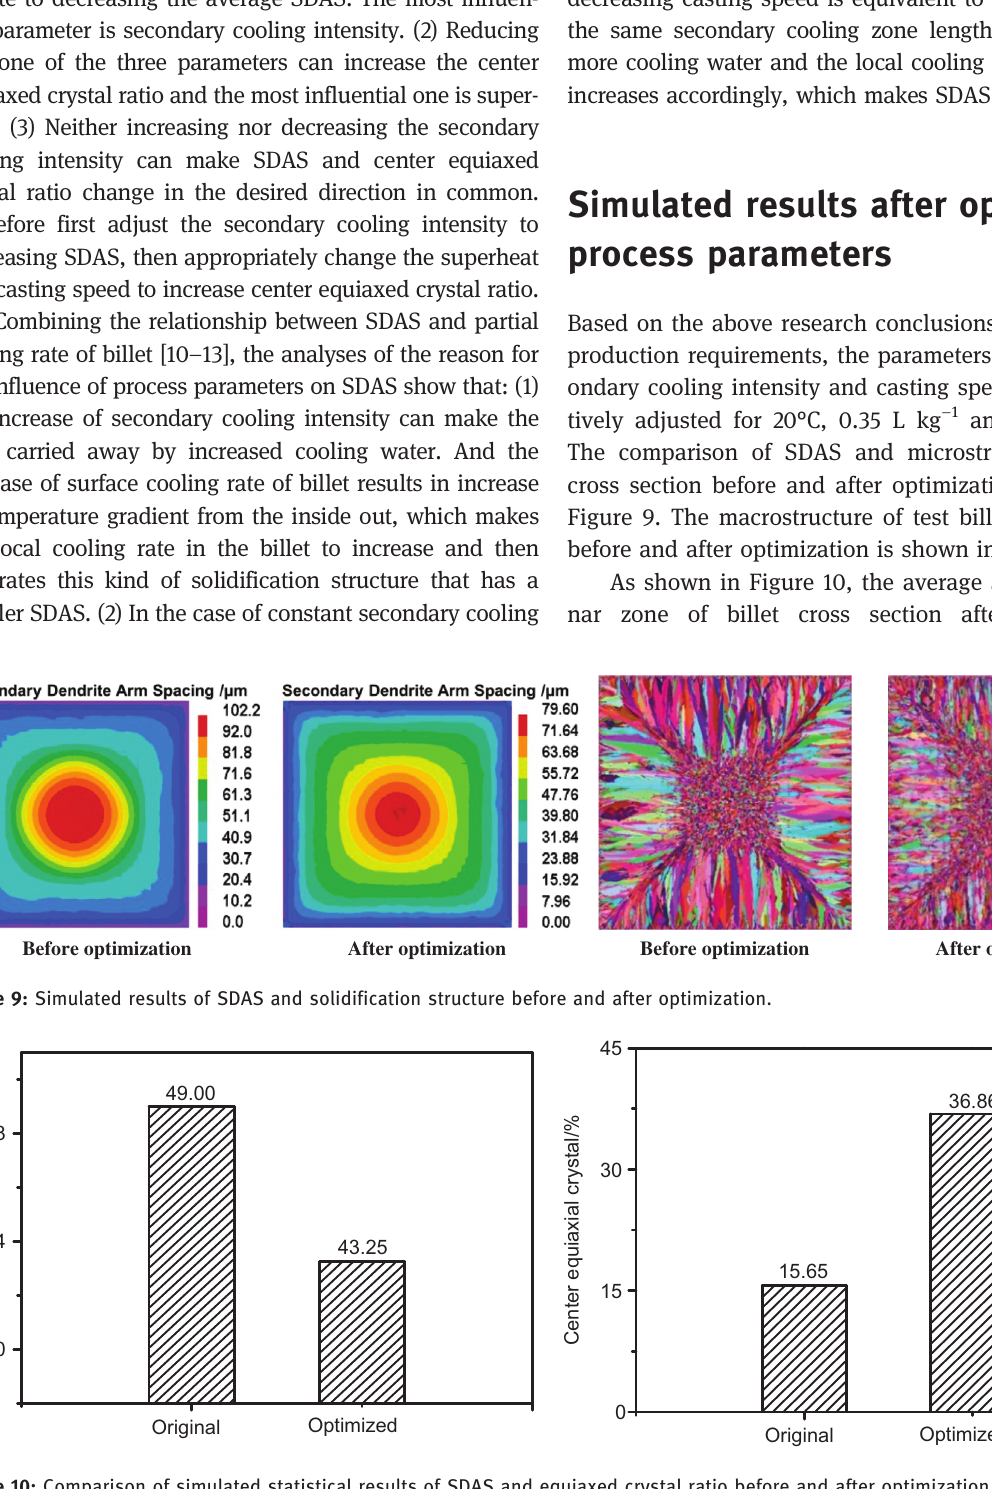
Figure 10: Comparison of simulated statistical results of SDAS and equiaxed crystal ratio before and after